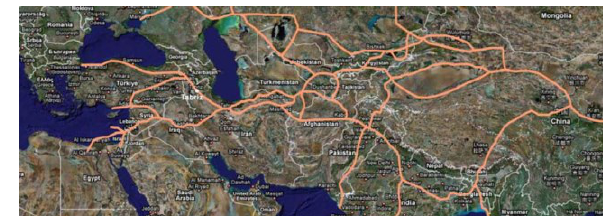
Figure 11 . The Location of Tabriz on the Silk Roads from 5th Century A.D. to beginning of 13th Century A.D. (UNESCO, 2009).